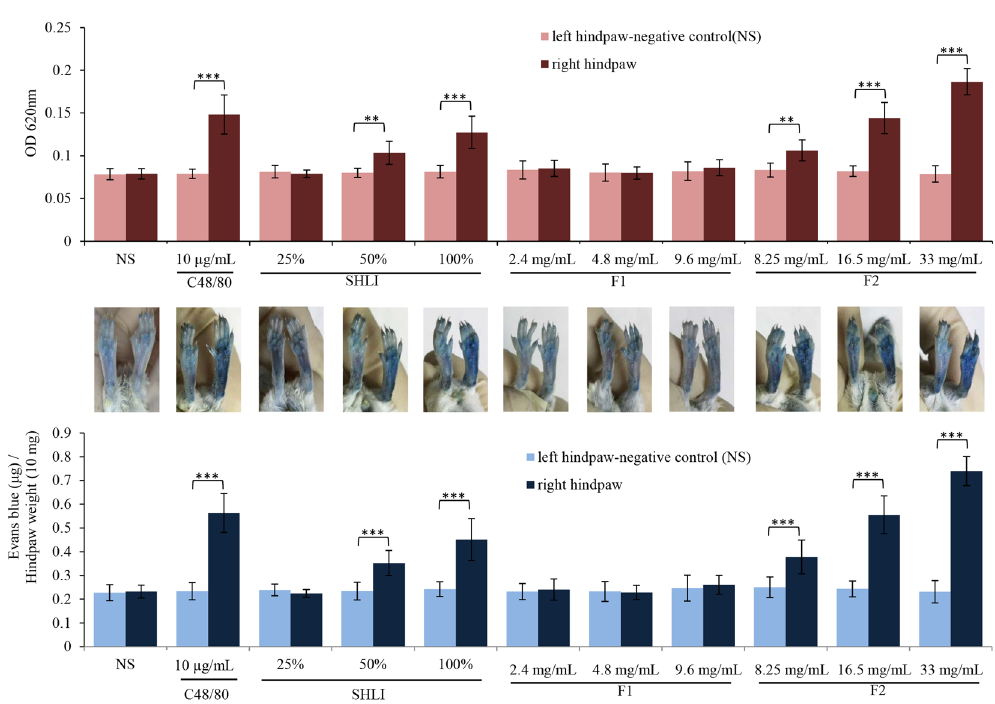
Figure 3. SHLI induces vasopermeability (Evans Blue extravasation) during the first intraplantar injection (n = 6). Fifteen minutes after induction of anesthesia (50 mg/kg of pentobarbital), mice were injected intravenously (i.v.) with 50 μ L of 12.5 mg/mL Evans Blue. Five minutes later, 5 μ L of the test substance (C48/80, SHLI, F1, or F2) was administered by intraplantar injection in the right paw and NS was administered in the left paw. Thirty minutes later, the mice were sacrificed and the paw tissue was collected, dried for 24 h at 50 °C, and weighed. Evans Blue was extracted by a 24 h incubation in formamide at 50 °C, and the OD value was read at 620 nm. ** P < 0.01 and *** P <